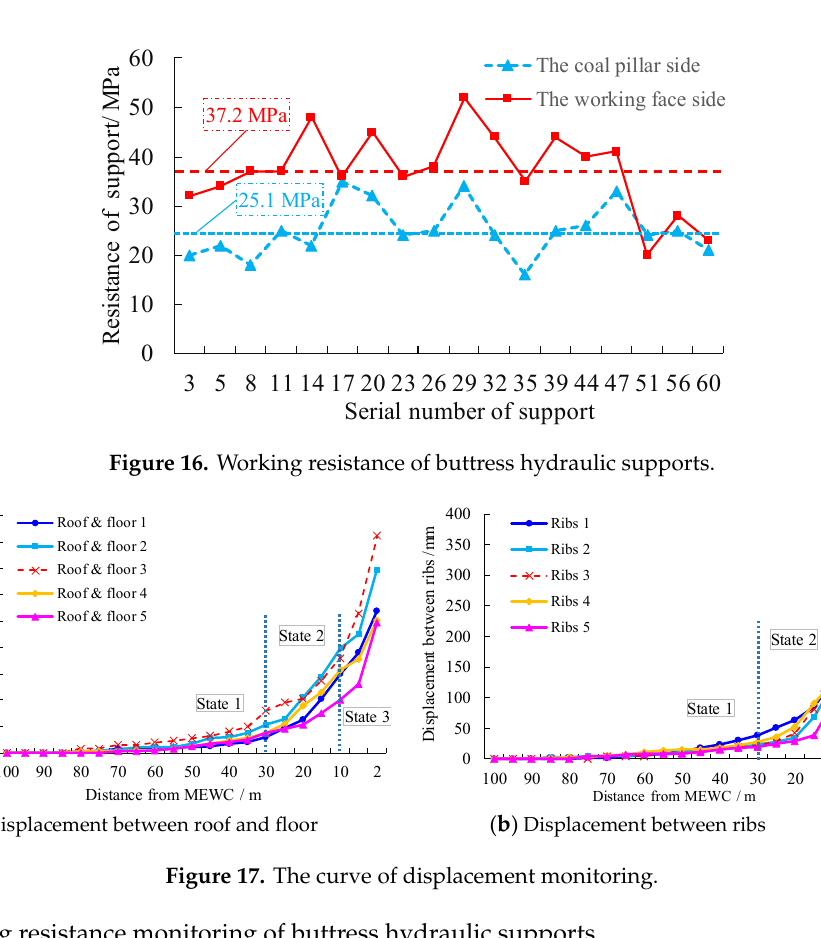
Figure 17. The curve of displacement monitoring.